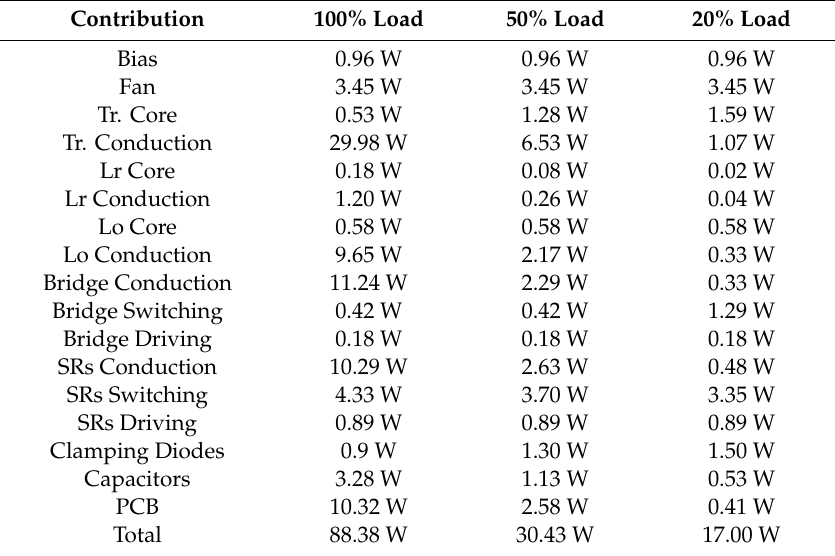
Table 12. Summary of the distribution of losses in the optimized design.